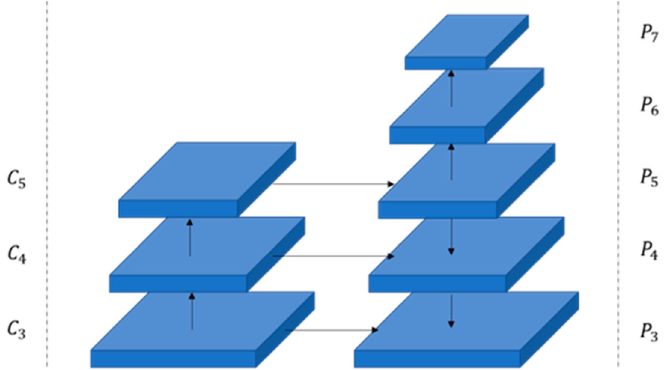
Figure 3. FCOS feature extraction